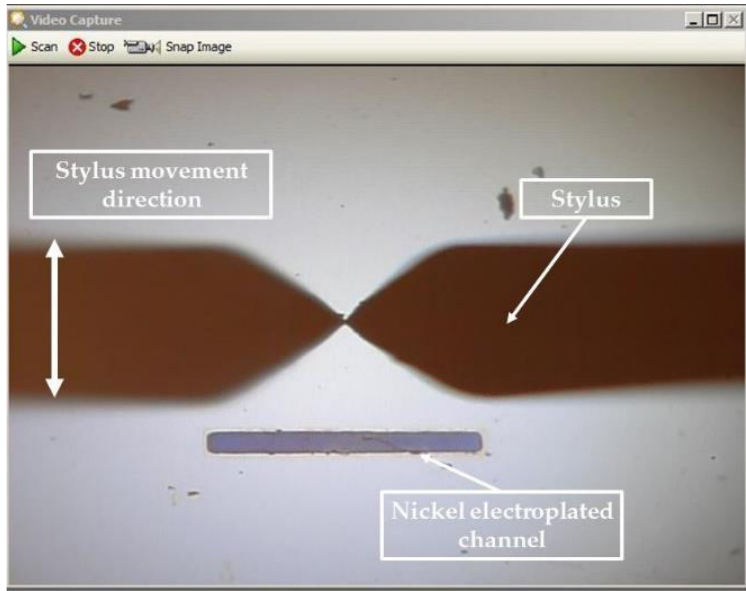
Figure 3. Measuring the surface roughness and thickness of the nickel layer using the profilometer.